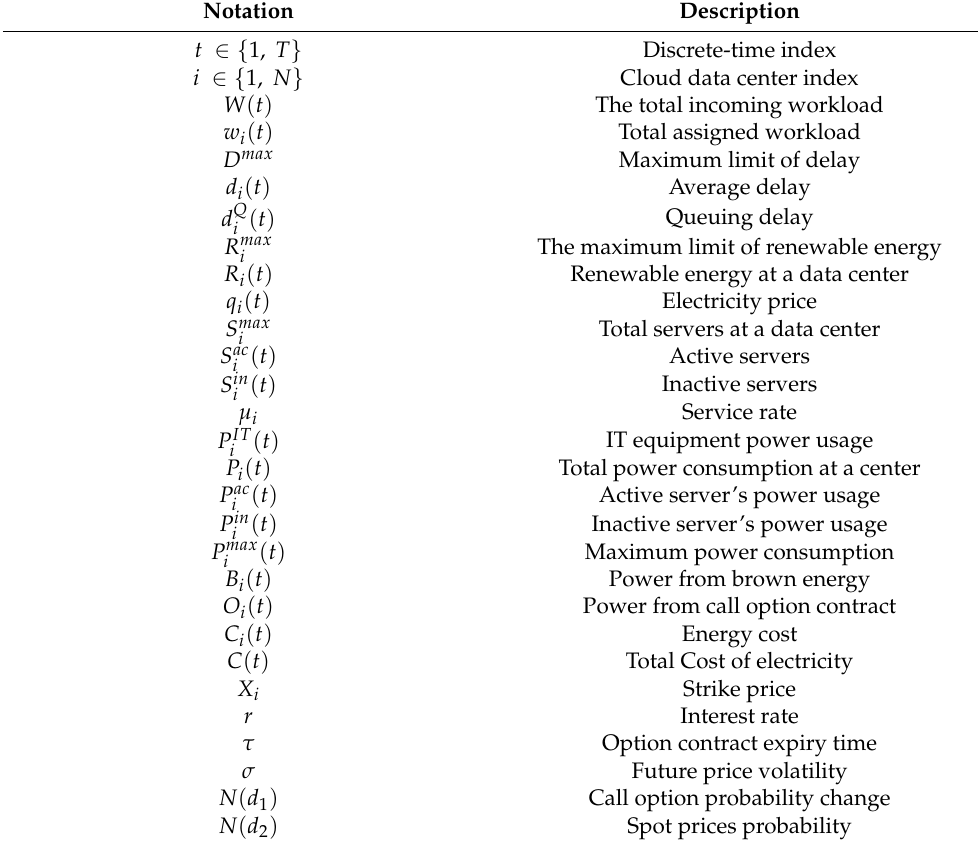
Table 1. Set of essential